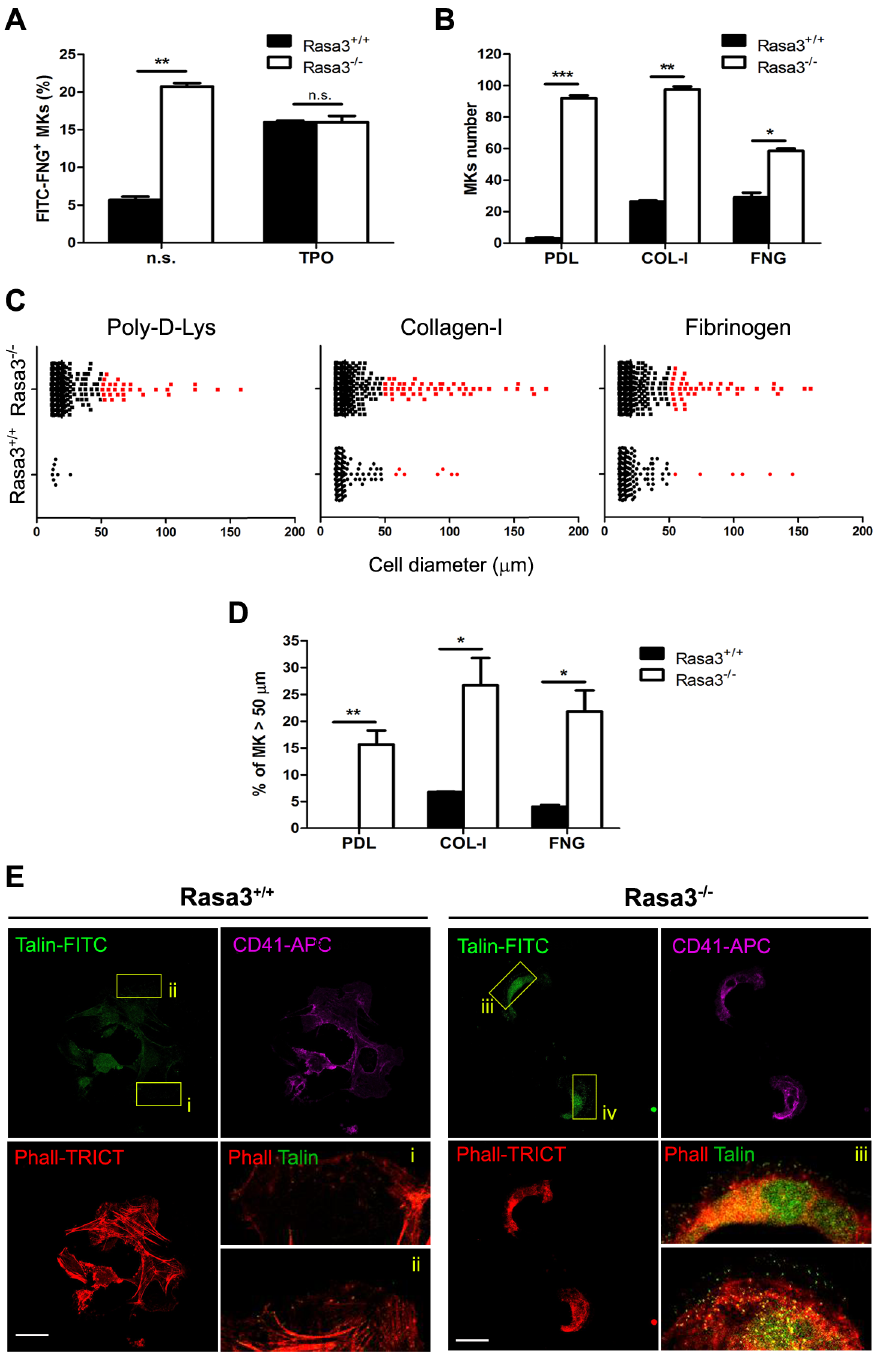
Figure 5. Altered inside-out and outside-in integrin signaling in Rasa3 2 / 2 megakaryocytes. Fetal liver cell (FLC) were isolated from E12.5 Rasa3 + / + and Rasa3 2 / 2 embryos and cultured with TPO for 3 days. Megakaryocytes were enriched on a BSA-gradient, deprived of serum for 4 hours and used in inside-out and outside-in integrin signaling assays. A. Inside-out a IIb b 3 integrin signaling was investigated in megakaryocytes by quantifying soluble FITC-fibrinogen (FITC-FNG) bound to the CD41 + cell surface by flow cytometry. Megakaryocytes were treated with or without 100 ng/ml TPO for 30 min. Specific binding was obtained after subtraction of the amount of soluble fibrinogen bound to the cell surface in the presence of EDTA and was expressed relative to the maximum binding obtained in the presence of MnCl 2 . A. U.: arbitrary units. n. s.: non stimulated. B. , C. , D. and E. Megakaryocytes were incubated for 18 hours on Poly-D-Lysine- (PDL), collagen-I- (COL-I) and fibrinogen- (FNG) coated plates in medium containing 10% FBS. Number ( B , mean 6 SEM) and diameter ( C ) of adherent megakaryocytes (MKs) was determined in 16 fields. Results are representative of 3 independent experiments. D . The percentage of Rasa3 2 / 2 adherent megakaryocytes with a diameter over 50 m m was significantly increased, as compared with Rasa3 + / + megakaryocytes (mean 6 SEM of 3 independent experiments). E. Rasa3 + / + and Rasa3 2 / 2 PDL-adherent megakaryocytes were stained with phalloidin-TRICT (actin, red), CD41-APC (magenta) and Talin-FITC (green). Confocal images were obtained from